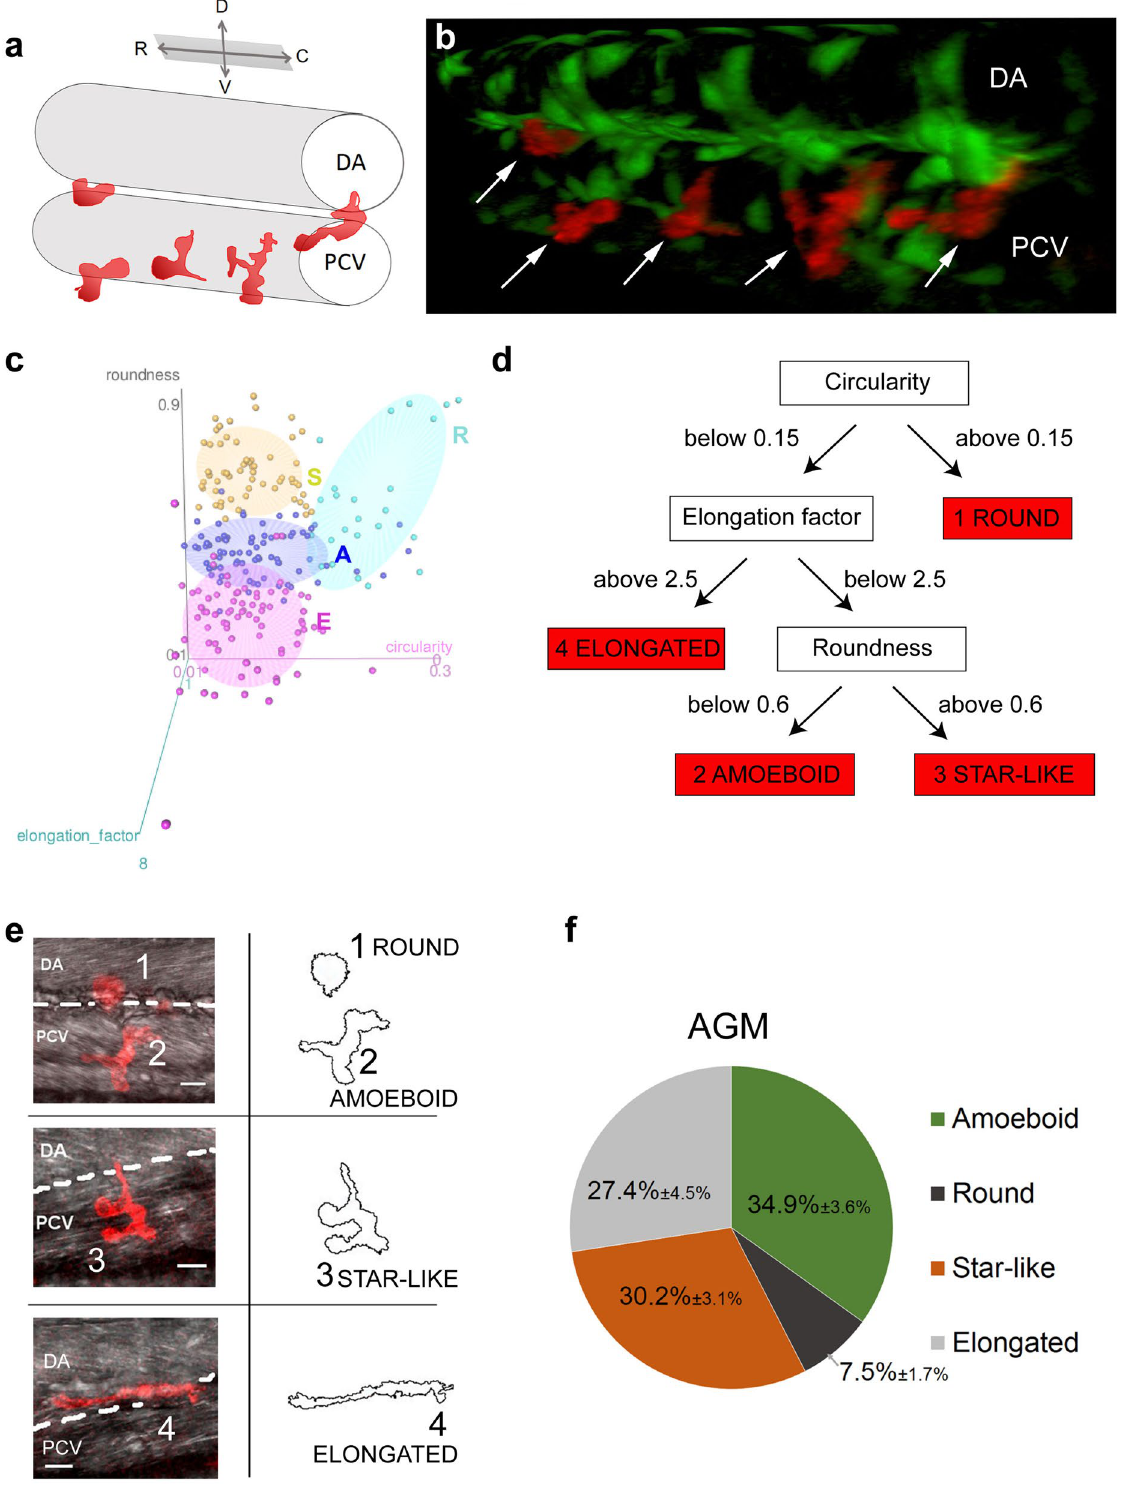
Figure 1. Macrophages in the AGM can be divided into 4 morphological subgroups. ( a ) The drawing shows a 3D view of vessels and macrophages (red) imaged in ( b ). ( b ) 3D view of the AGM in the mid-trunk region of a Tg(kdrl:eGFP//mpeg1:mCherry-F) zebrafish embryo at 48 hpf showing the position of vessels (endothelium in green) and macrophages (in red, white arrows) in the outer side of the vein and in between the dorsal aorta and the cardinal vein. ( c ) 3D scatter plot showing the 3 attributes (circularity, roundness and elongation factor) used to divide macrophage to their shape categories; plot was generated in R using rgl package 25 . ( d ) Diagram of the decision chart for the 4 categories of macrophages delineated according to shape attributes. ( e ) Representative confocal images (maximum intensity projections) of individual categories with an outline drawing from particle analysis on the right. ( f ) Graph representing the percentage distribution of the different shape categories per AGM. Data are represented as percentage average ± s.e.m. N = 20 embryos. C caudal, D dorsal, DA dorsal aorta, PCV posterior cardinal vein, R rostral, V ventral. See also Supplementary table